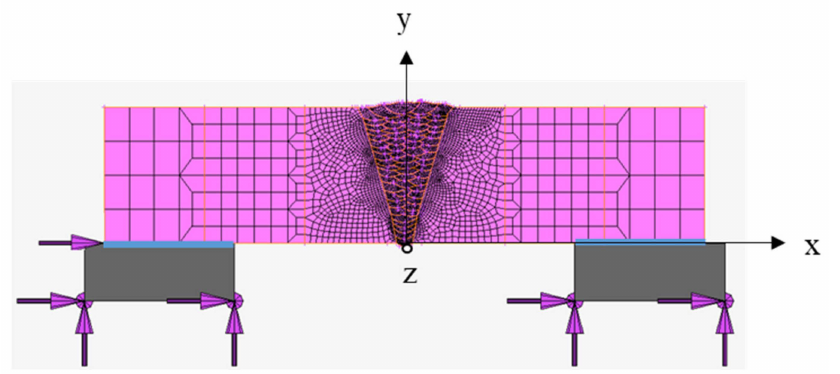
Figure 4. Boundary conditions for 2D